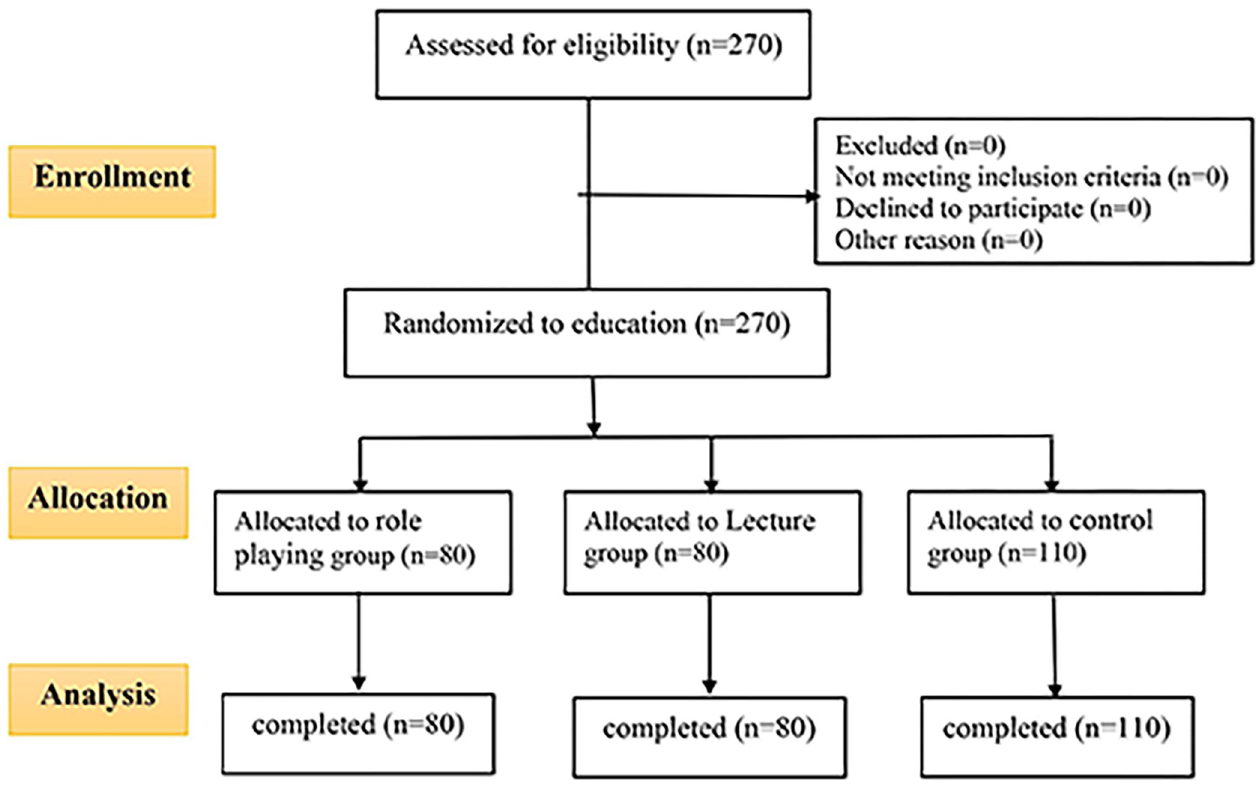
Fig 1. CONSORT flow diagram of participant